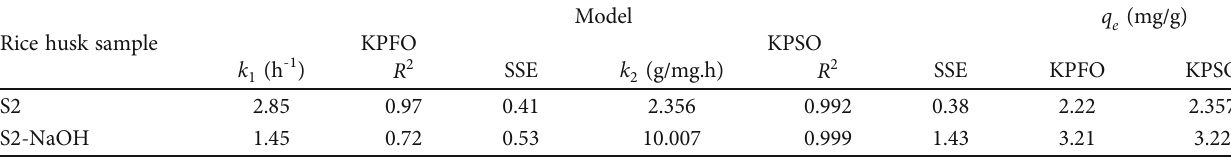
Figure 10: Percentage of cadmium removal by S2 and S2-NaOH ( pH = 7 , 10mg/L of Cd (II), and 150mg of biosorbent). Table 3: Values of the pseudo fi rst and second order kinetic